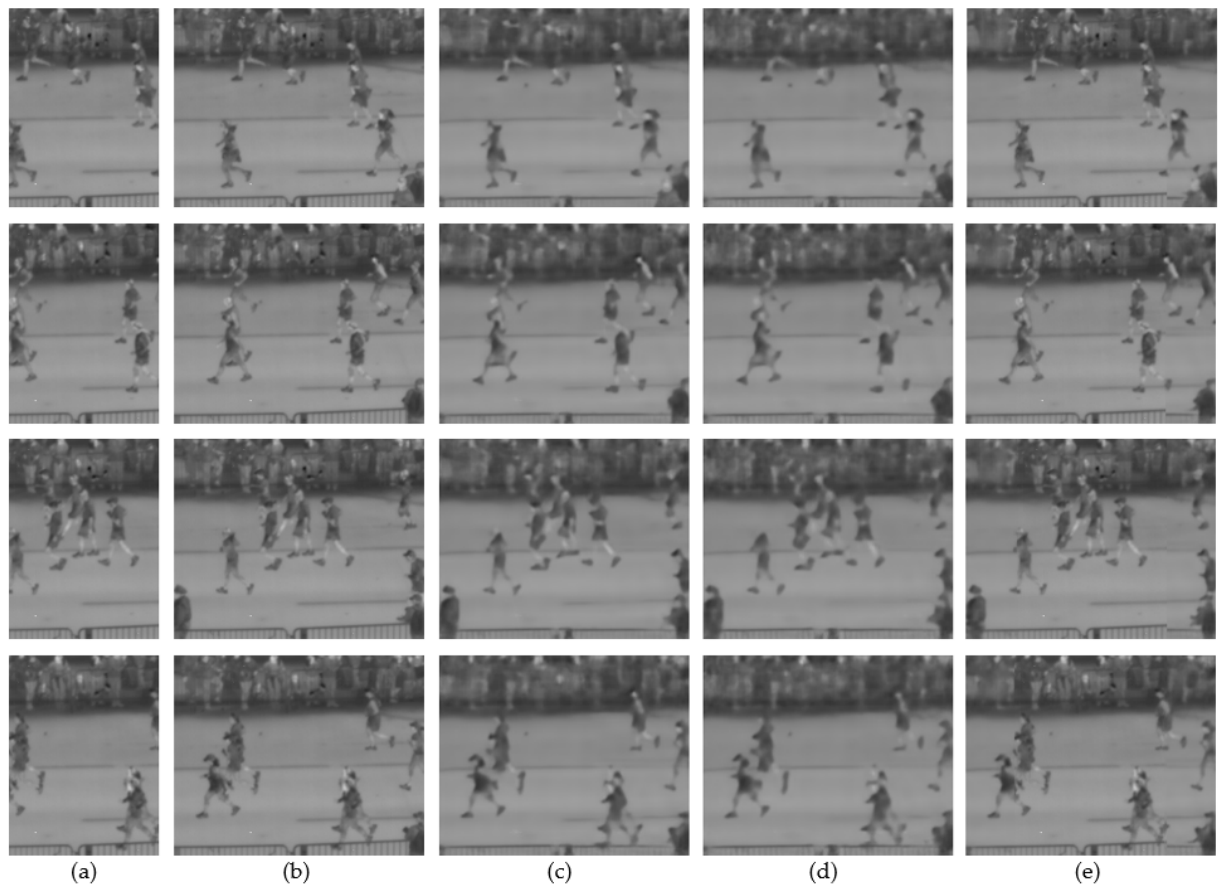
Figure 12. Comparisons of original images, GT images, and the prediction results obtained by the state-of-the-art methods and the proposed method: ( a ) original images, ( b ) GT images, and images predicted by ( c ) Shin et al. [19], ( d ) Nazeri et al. [21], and ( e ) the proposed method.